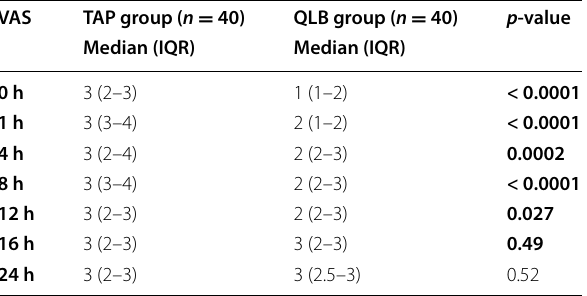
Table 4 Difference between TAP group and QLB group postoperative pain score